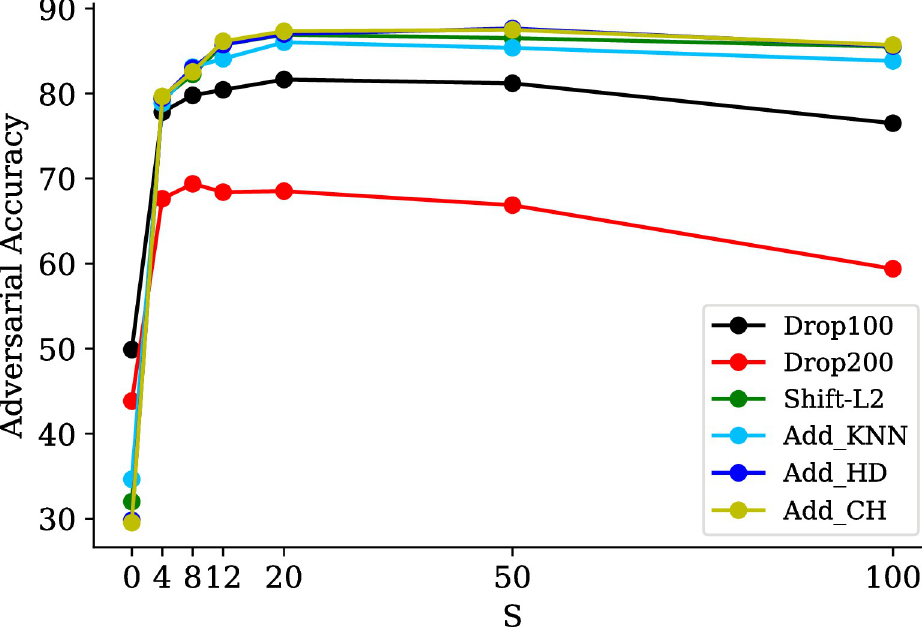
Fig 8. Effect of different S . LPF 2 results of PointNet model on ModelNet40 dataset. Results are tested on six adversarial attacks. Numbers on horizontal axis indicate the degree of low pass versions with different S